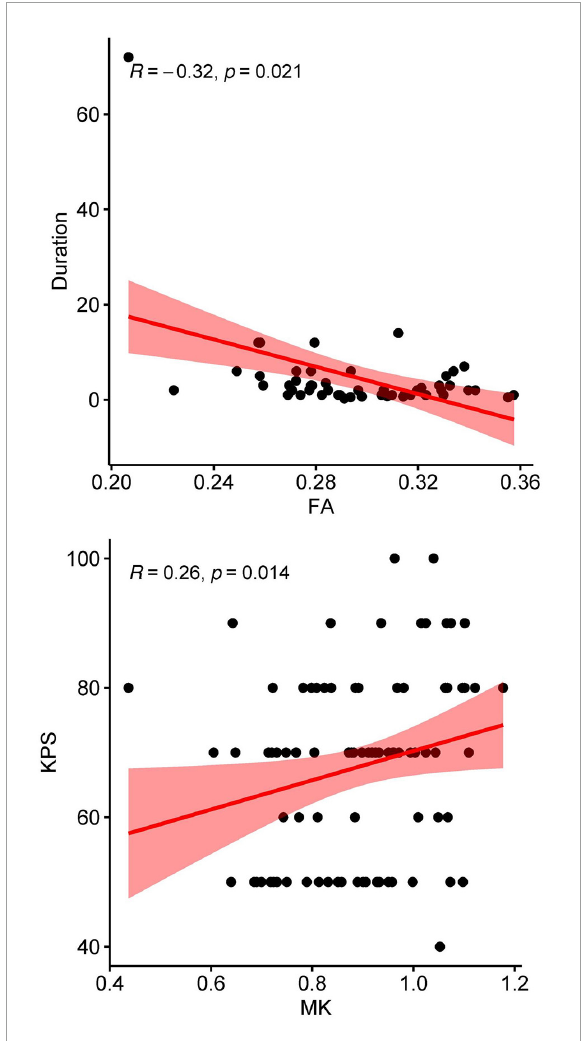
FIGURE5 Correlation between the DKI-derived values and symptom duration and KPS scores of patients: top: correlation between FA of the right ICP and symptom duration; bottom: correlation between MK of the MCP and the preoperative KPS score (as right ICP in 43 cases failed to be reconstructed, the right ICP of 57 cases were used for correlation